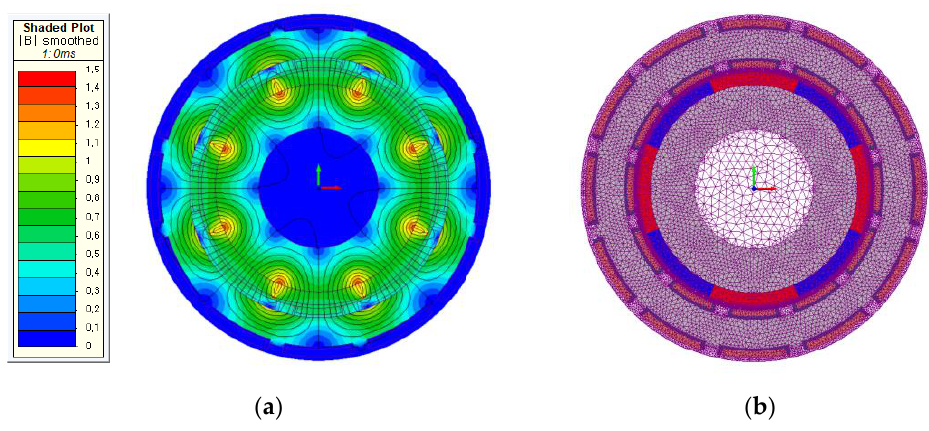
Figure 16. FEA 2D Model of the prototype: ( a ) Flux density distribution, and ( b ) Mesh.